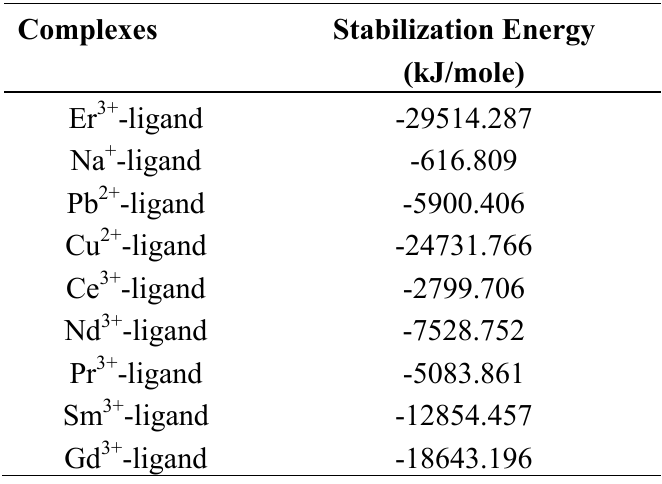
Table 1. Interaction energy between metal ions – ligand